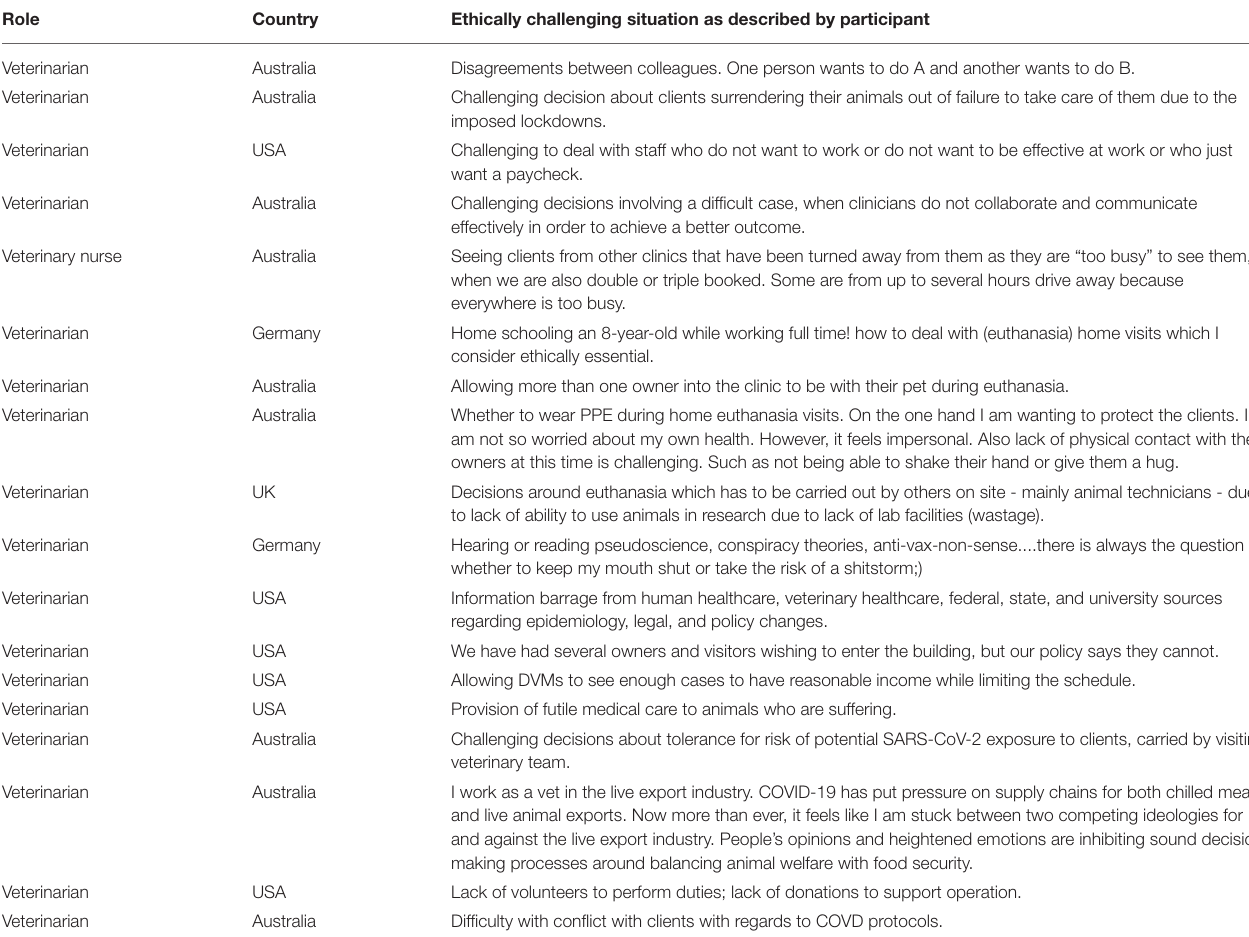
TABLE 3 | Other situations where decision-making may be ethically challenging, as described by participants.